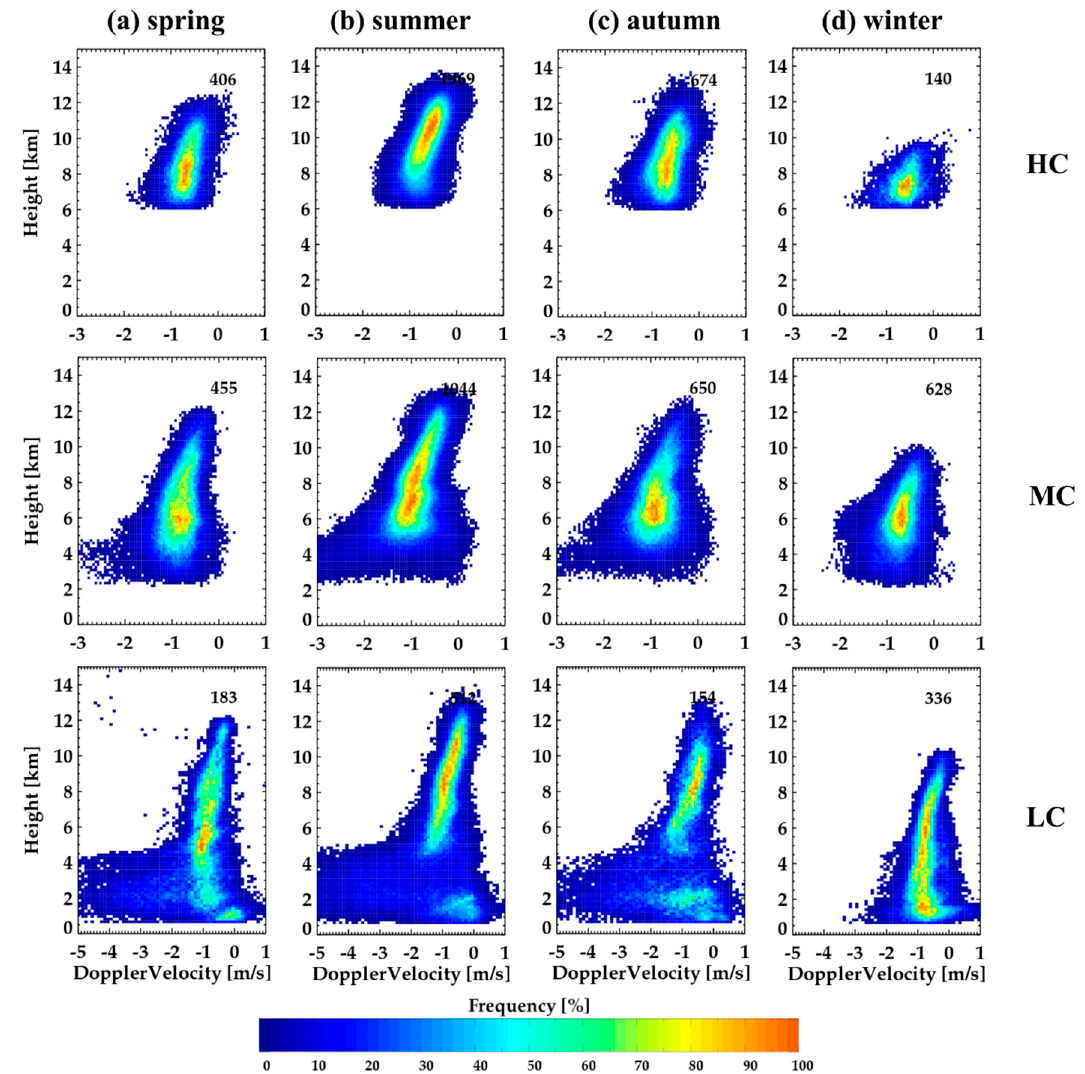
Figure 13. The same as in Figure 12 except for the CFADs of the Doppler radial velocity. ( a ) Spring, ( b ) summer, ( c ) autumn, and ( d )